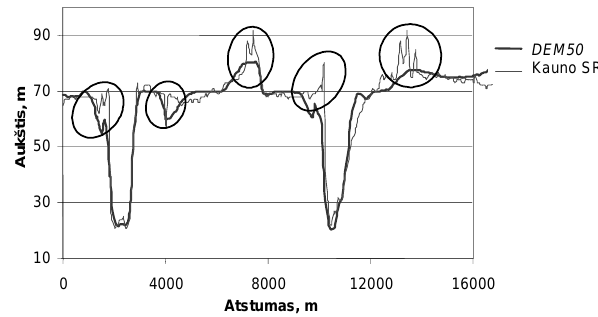
Fig 4. Above-ground objects reflecting on Kaunas